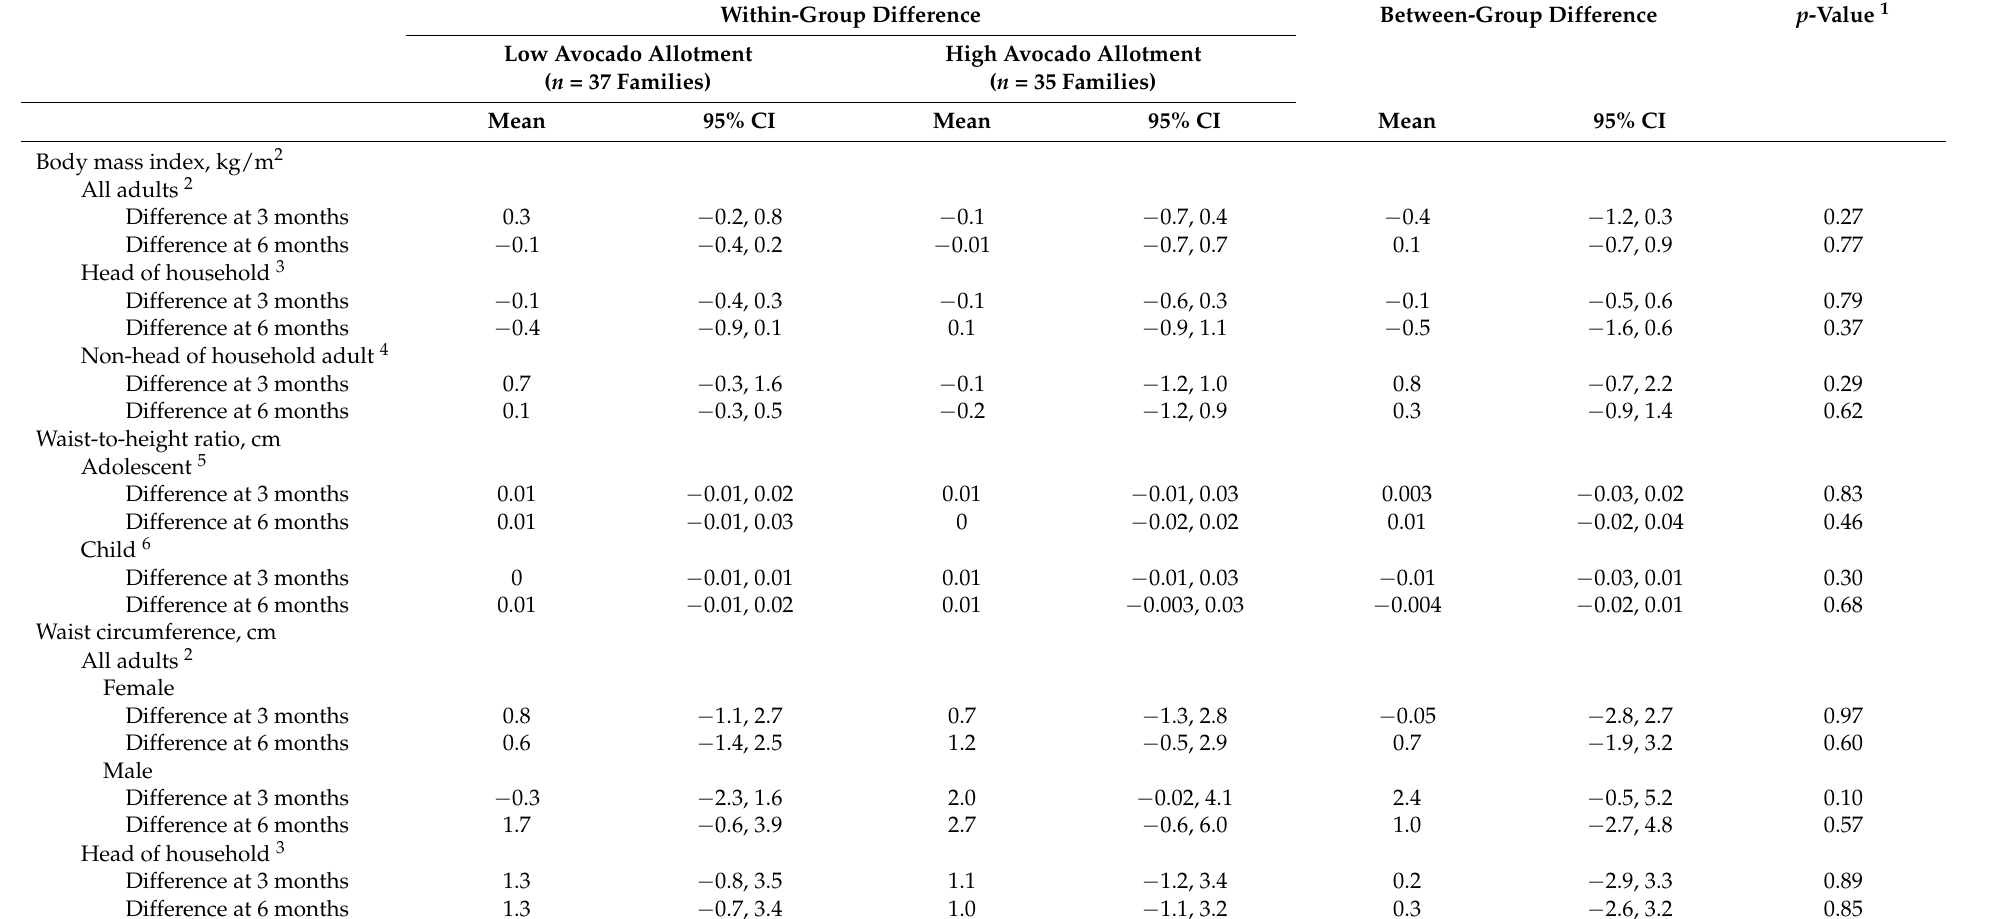
Table 5. Changes in family members’ body mass index, waist circumference, and blood pressure, per intention-to-treat analysis in the Effects of Avocado Intake on the Nutritional Status of Families Trial ( n = 72